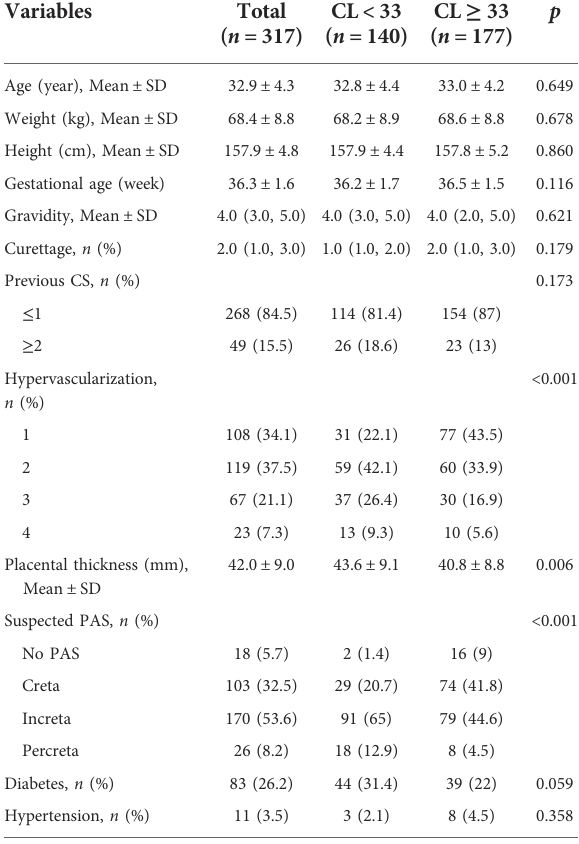
TABLE 1 Baseline characteristics of the study